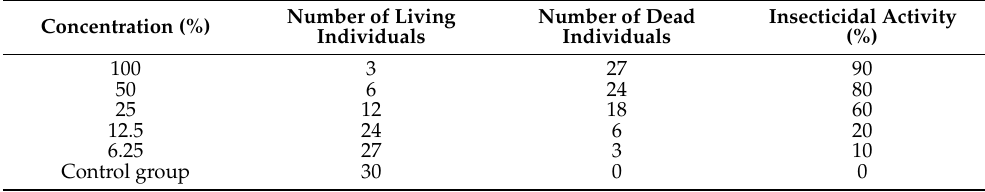
Table 7. Insecticidal activity of